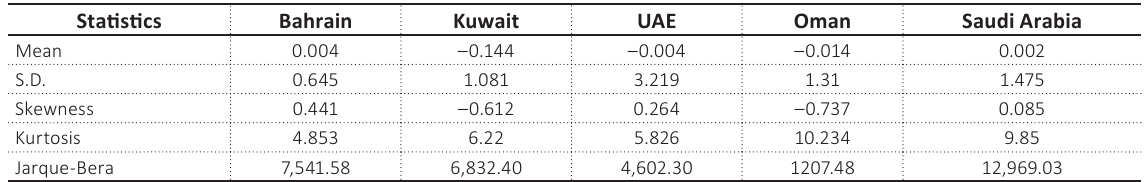
Table 1. Descriptive statistics for GCC banking portfolio daily returns